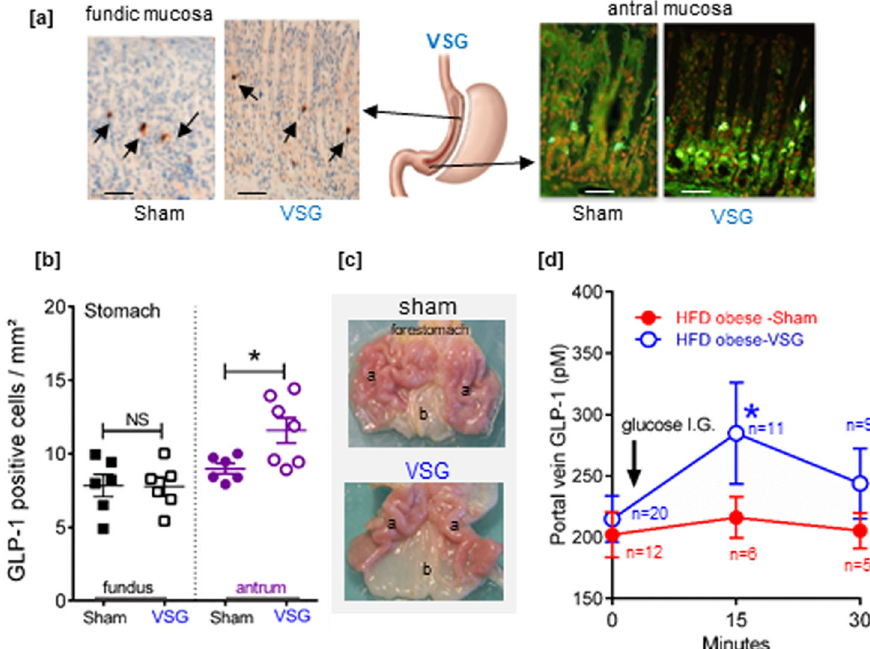
Fig. 5 The density and functionality of GLP-1-positive cells in the antral mucosa increases after VSG surgery in rats. a Representative photomicrographs of GLP-1 immunoreactive cells in the remaining fundic mucosa (left) and antral mucosa (right) in HFD obese rats operated on Sham or VSG. Bar scale 100 µ m. Note that on right panel immuno fl uorescent GLP-1-positive cells are in green with nuclei in red. The included image is the property of Johnson and Johnson and Ethicon Endo-Surgery (Europe) and is reproduced here with their kind permission. b Quanti fi cation of the number of GLP-1 immunoreactive cells per mm 2 in the fundic and antral mucosa. The data are presented as scatter data plots (each point represents one rat) with mean ± SEM and analyzed using Mann – Whitney test * P < 0.05, NS not signi fi cant. c Postmortem macroscopic photomicrographs of stomach [fundus/corpus (a), antrum (b)] of HFD obese rats operated on sham or VSG, 2 weeks after surgery. Note the enlargement of the antrum (b) in VSG-rat. d Portal vein GLP-1 levels after an intragastric load of glucose (2 g/kg BW) in anesthetized sham- and VSG-operated HFD rats. Data represented the mean ± SEM of n values indicated at each time point on the graph for HFD obese Sham rats and HFD obese rats operated on VSG surgery. Data were analyzed by a two-way ANOVA. * P < 0.05 vs. sham. Source data are provided as a Source data fi